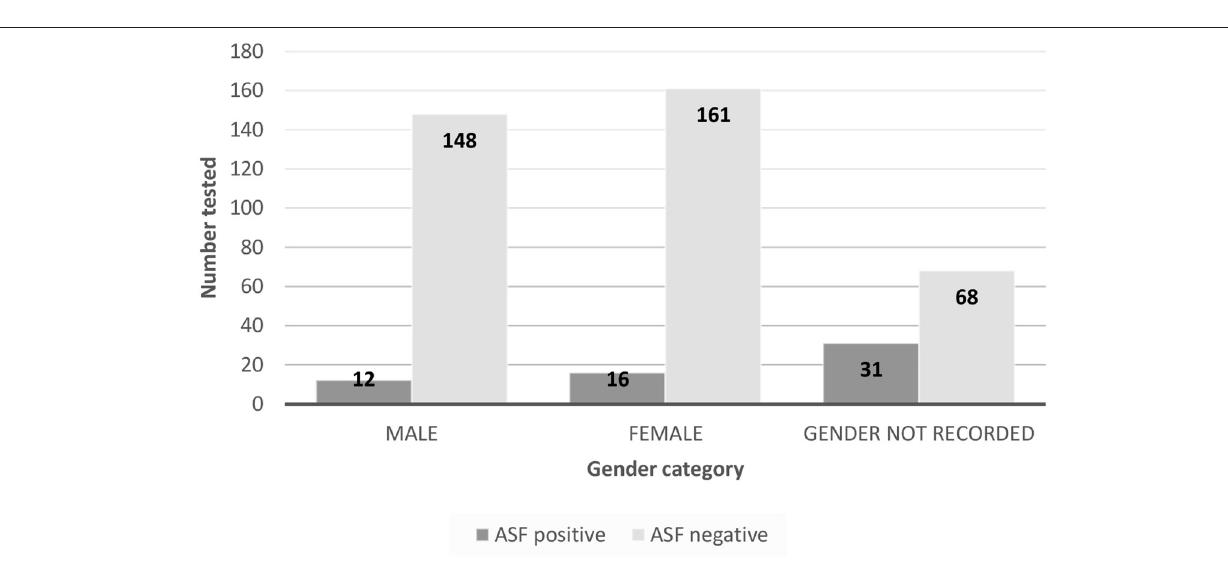
FIGURE 3 | Summary of ASF test results versus gender of pigs sampled for mainland prevalence and Atauro Island